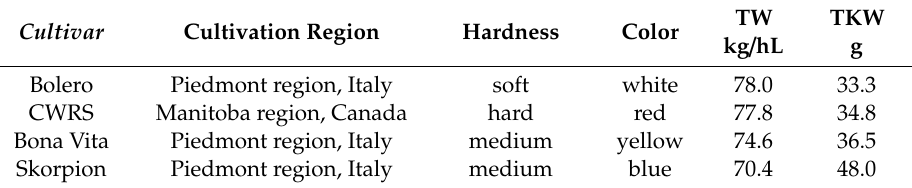
Table 1. Main information of common wheat